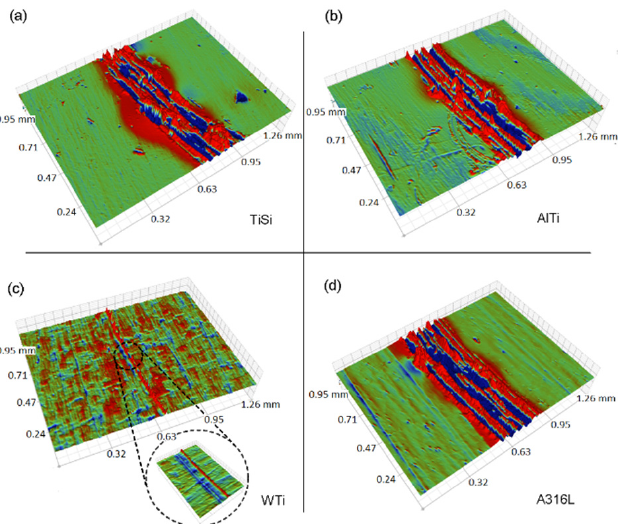
Figure 6. Images of the wear traces obtained via profilometry: ( a ) TiSi coating, ( b ) AlTi coating, ( c ) WTi coating, and ( d ) AISI 316L steel substrate.